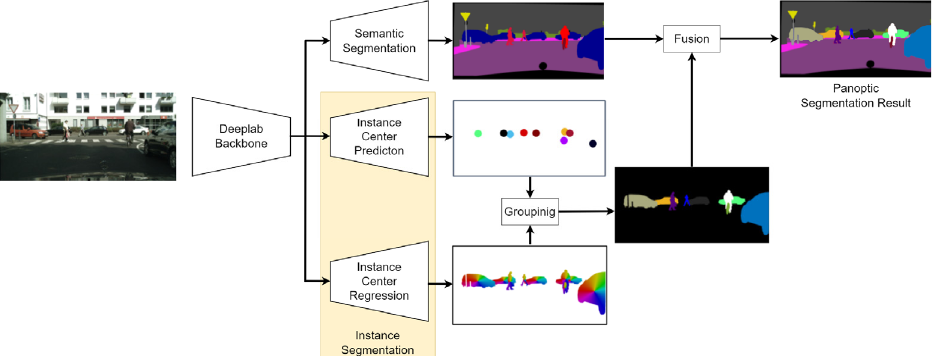
Figure 7. Overall Panoptic Deeplab